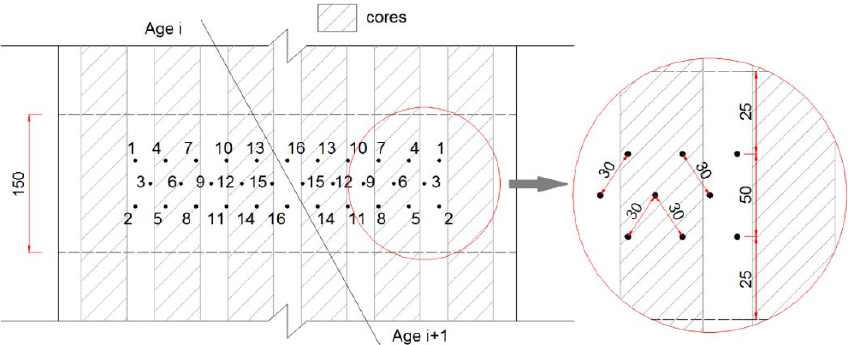
Figure 10 – Location of the measurements in the hollow-core bands (Note: units in mm).